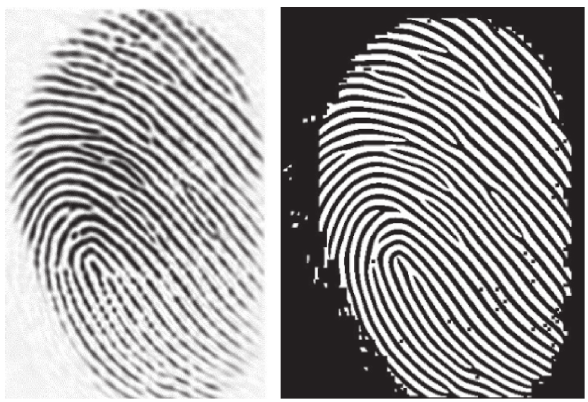
Figure 14: Input fingerprint image (left) and binarized image (right).